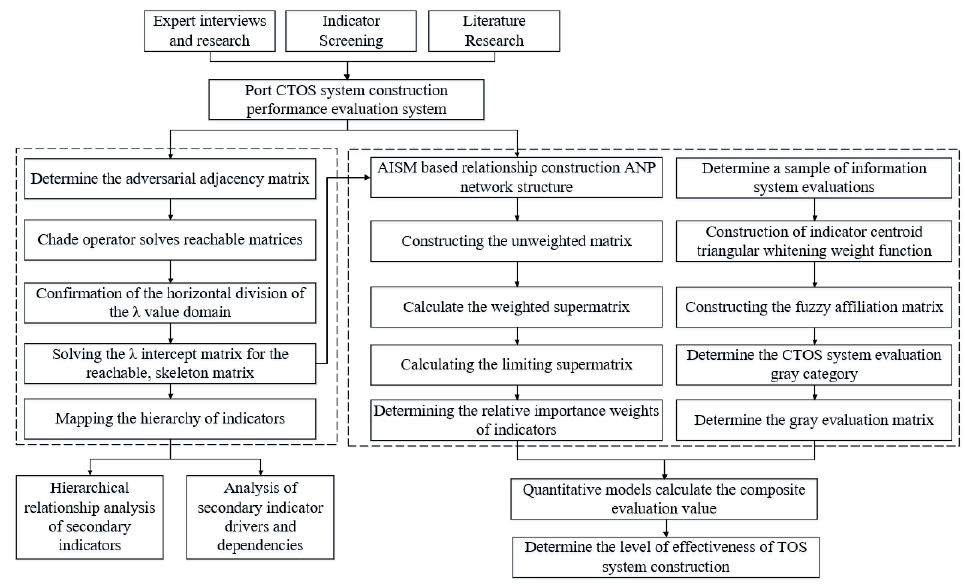
Figure 1. Technical roadmap.